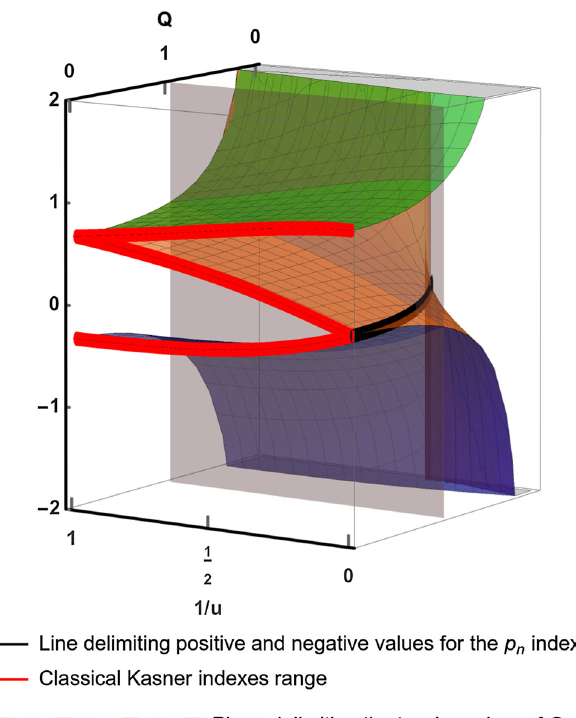
Fig. 6 Plot of the “spectrum” of the Kasner indices in the ( u , Q ) - parametrization (96). Every value of ( u , Q ) in the dominion u ∈ [ 1 , ∞ ) and Q ∈ [ 0 , 1 ] uniquely selects a triplet of Kasner indices. The vertical plane delimits the two branches of the ( u , Q ) -parametrization (96). The connected-branch is the one containing the red (dark gray) lines, i.e. the standard parametrization shown in Fig. 1. The Q parameter of the connected-branch is increasing from 0 to 1 in the positive direction of the Q -axis, while for the disconnected-branch it is decreasing from 1 to 0. The black line delimits the part of the ( u , Q ) -plane where there is only one (above) or two (below) negative Kasner indices. The plot is cut on the bottom and on top but it is actually extending up to